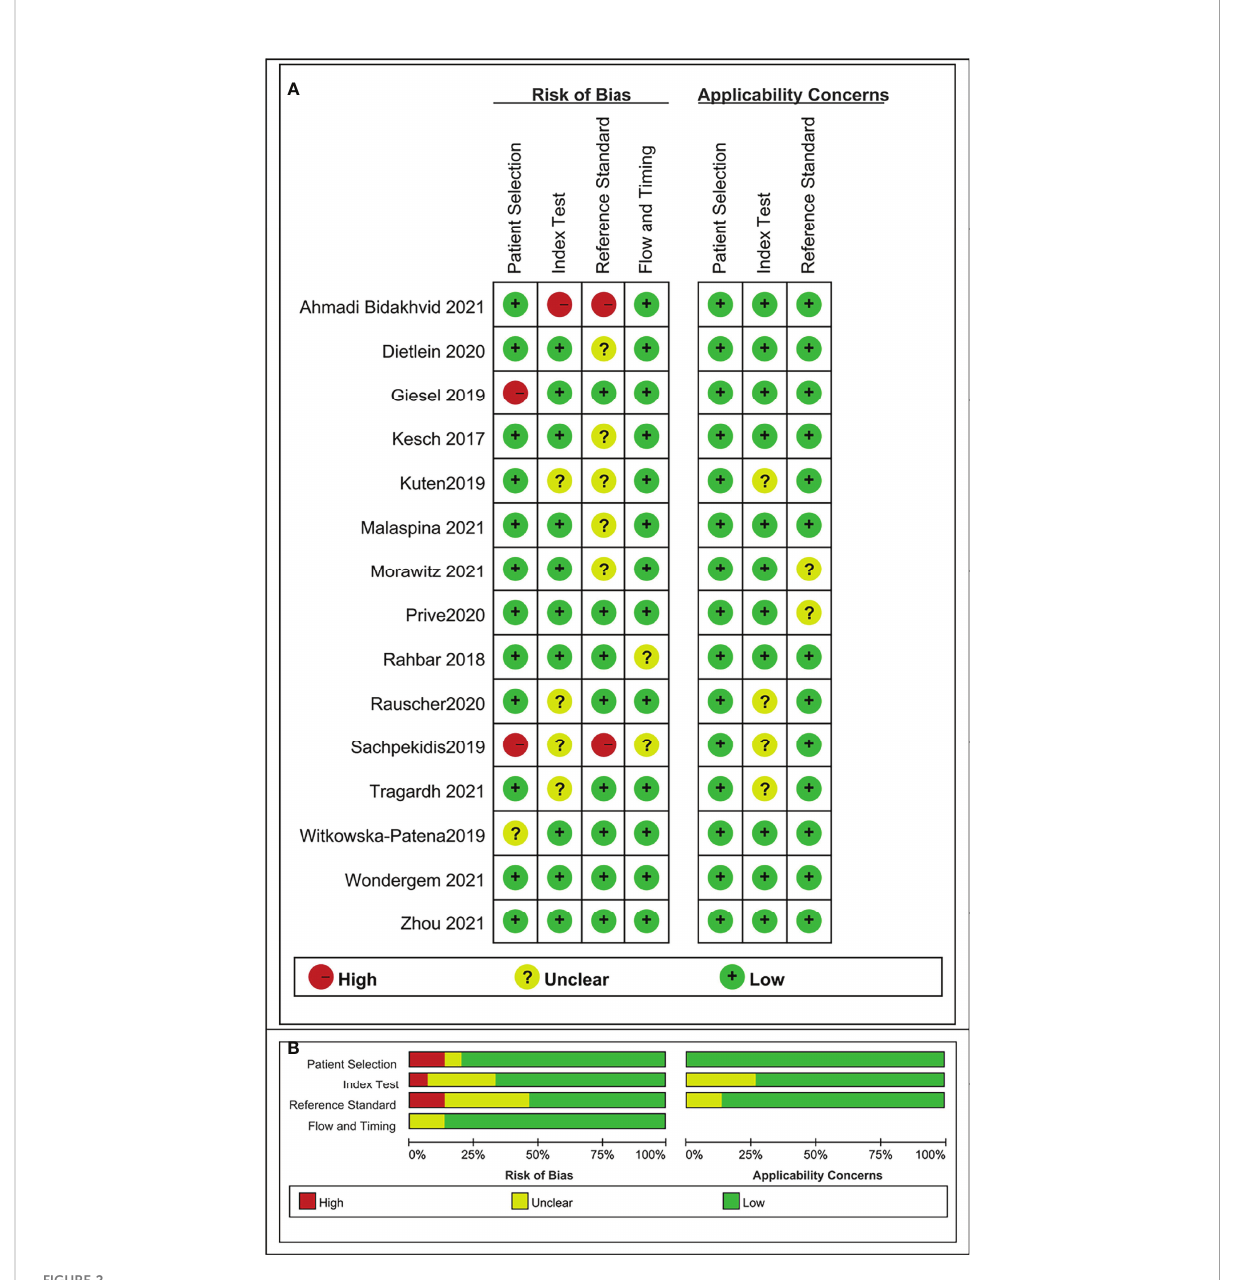
Figure 4B . Egger ’ s regression intercept for DR pooling was − 2.70 (95% CI: − 5.81 to 0.41, P = 0.079), also indicating that publication bias was